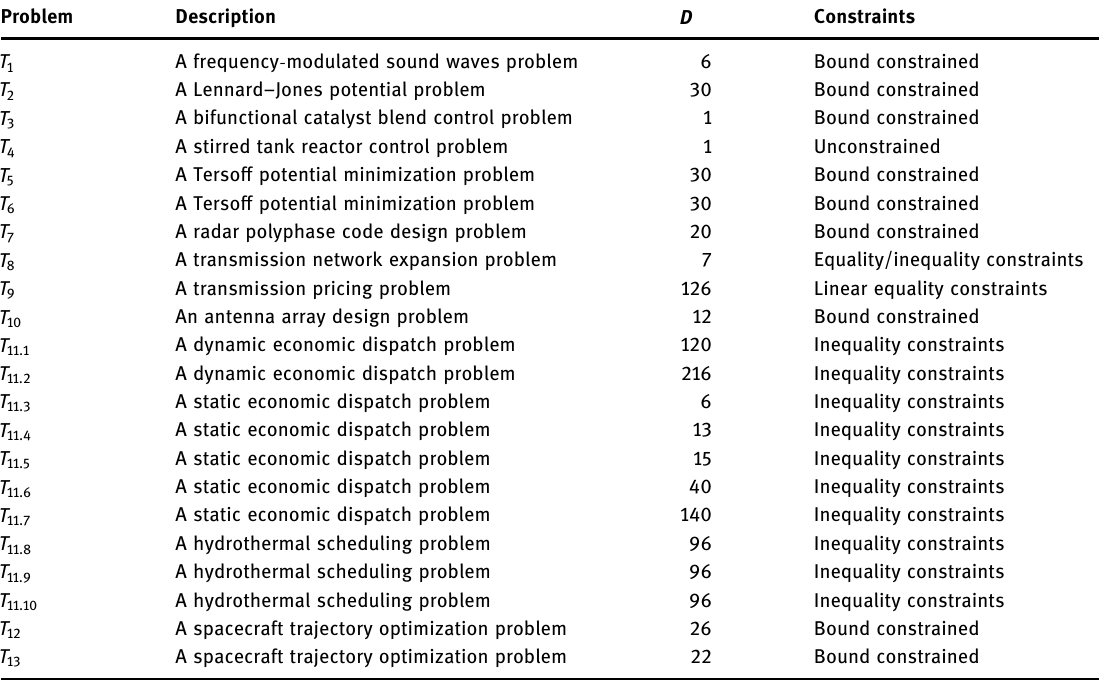
Table 2: Summary of the CEC 2011 real - world problems